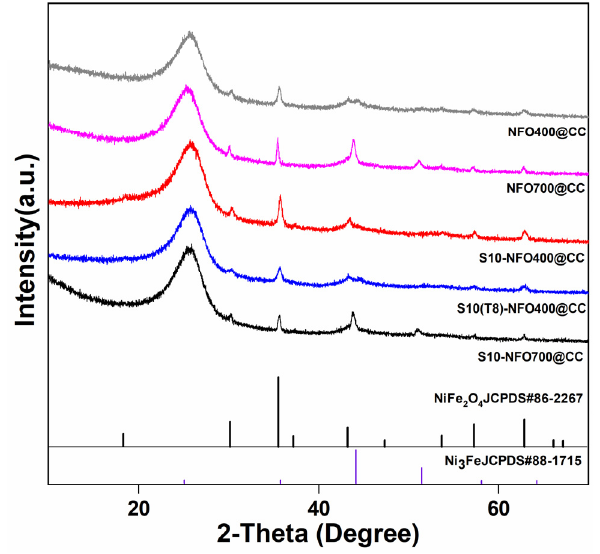
Figure 2. XRD patterns of NFO400@CC (gray curve), NFO700@CC (magenta curve), S10-NFO400@CC (red curve), S10(T8)-NFO400@CC (blue curve), S10-NFO700@CC (black